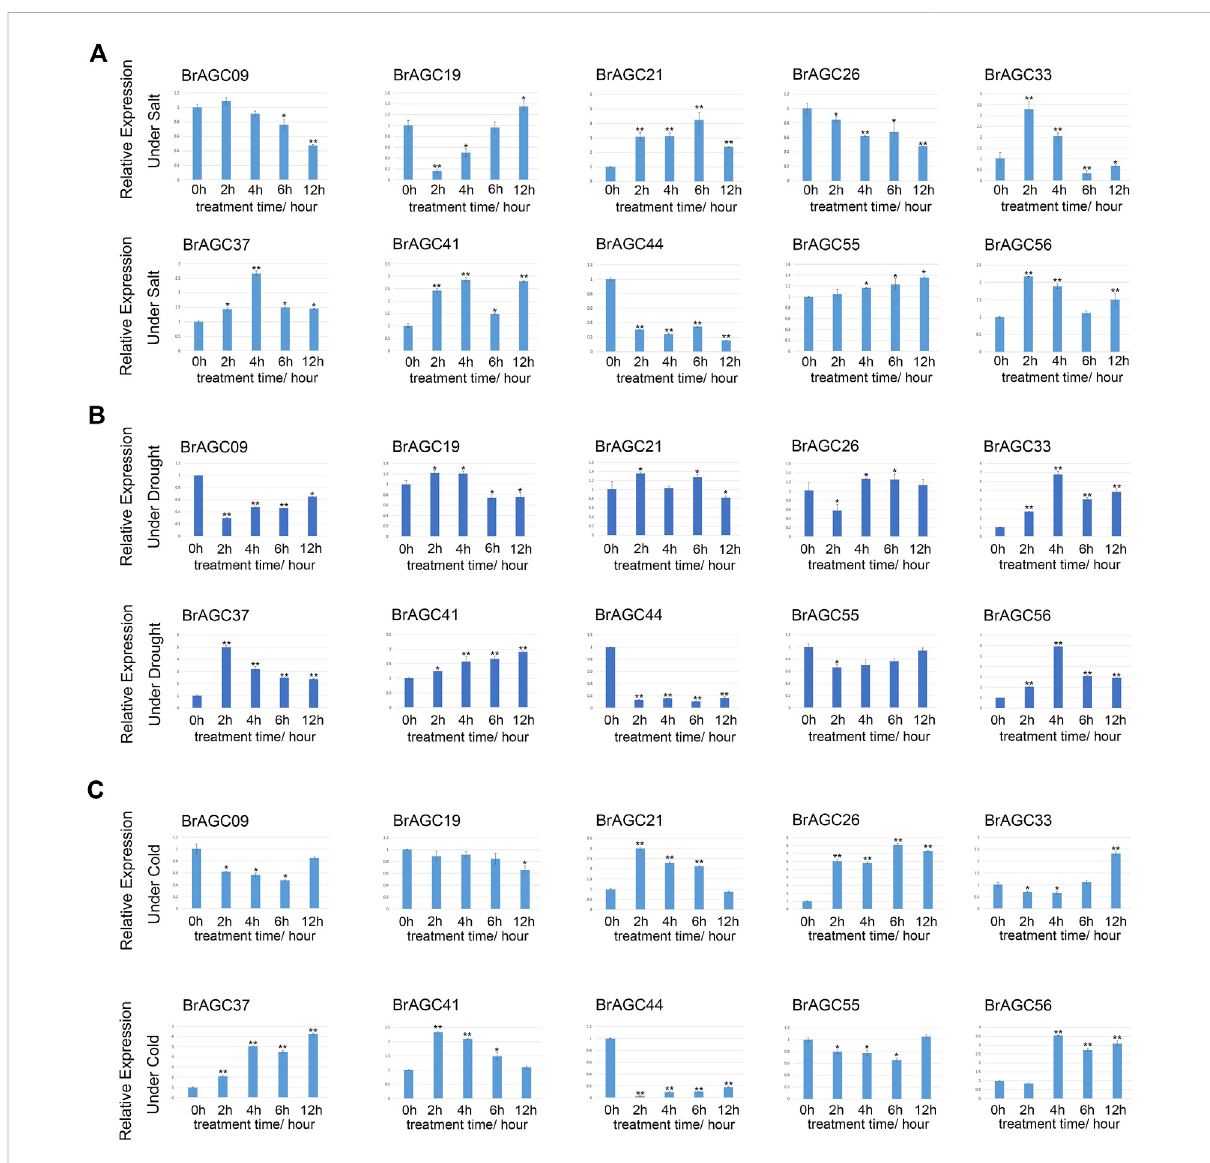
FIGURE 8 Expression pro fi les of 10 BrAGC genes under abiotic stress were analyzed by qRT-PCR. (A) Salt treatment. (B) Drought treatment. (C) Cold treatment. The above experiments were performed using 0 h as the control, and the treatment time was set to 2, 4, 6, and 12 h. Each group was subjected to three biological replicates, and error bars indicate standard errors. Asterisks above data bars indicate statistical signi fi cance (two-tailed t -test; * p < 0.05; ** p <